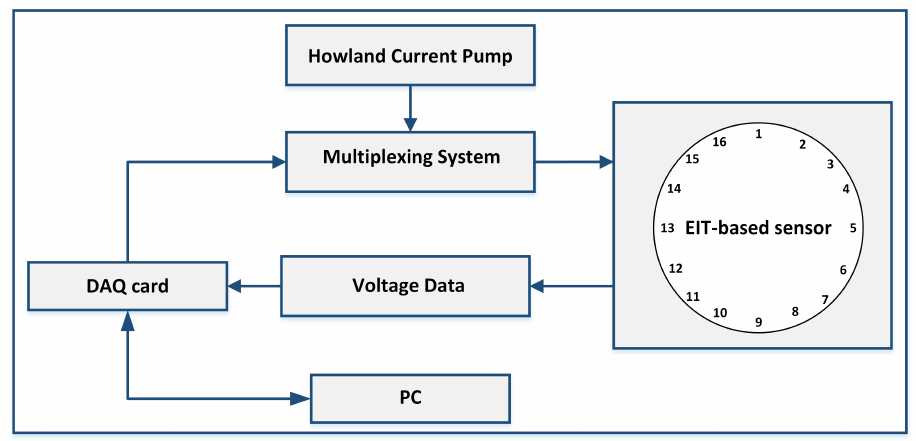
Figure 5. Block diagram of EIT hardware system for current injection and voltages